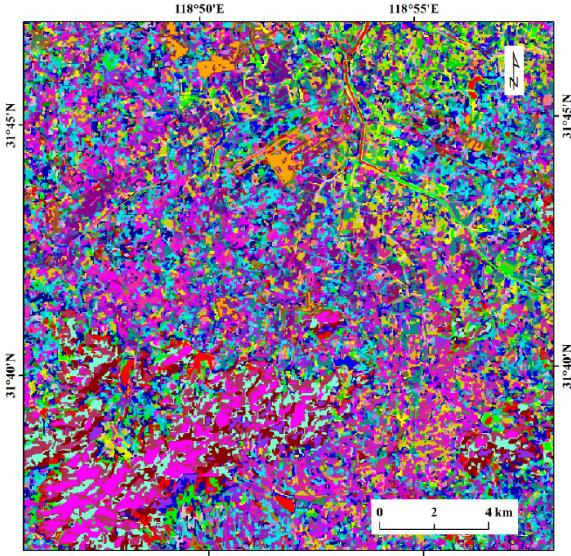
Figure 5. The patch-based ISODATA classification map with 40 classes ( i.e ., n unmixing the three MOD09GA images in the